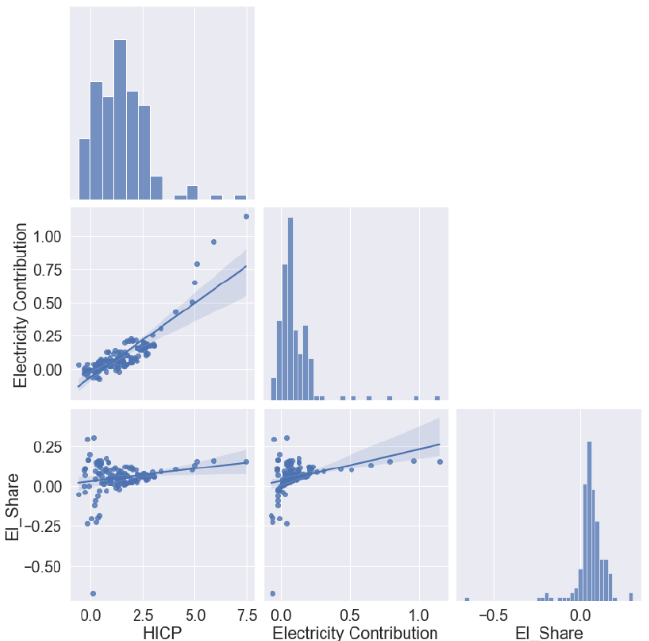
Figure 5 : Di stributions and scatterplot between electricity share on HICP(El_share), electricity contribution to HICP as given by Eurostat and HICP in the period after 2010. Source dataset: Eurostat: PRC_HICP_CTRB.